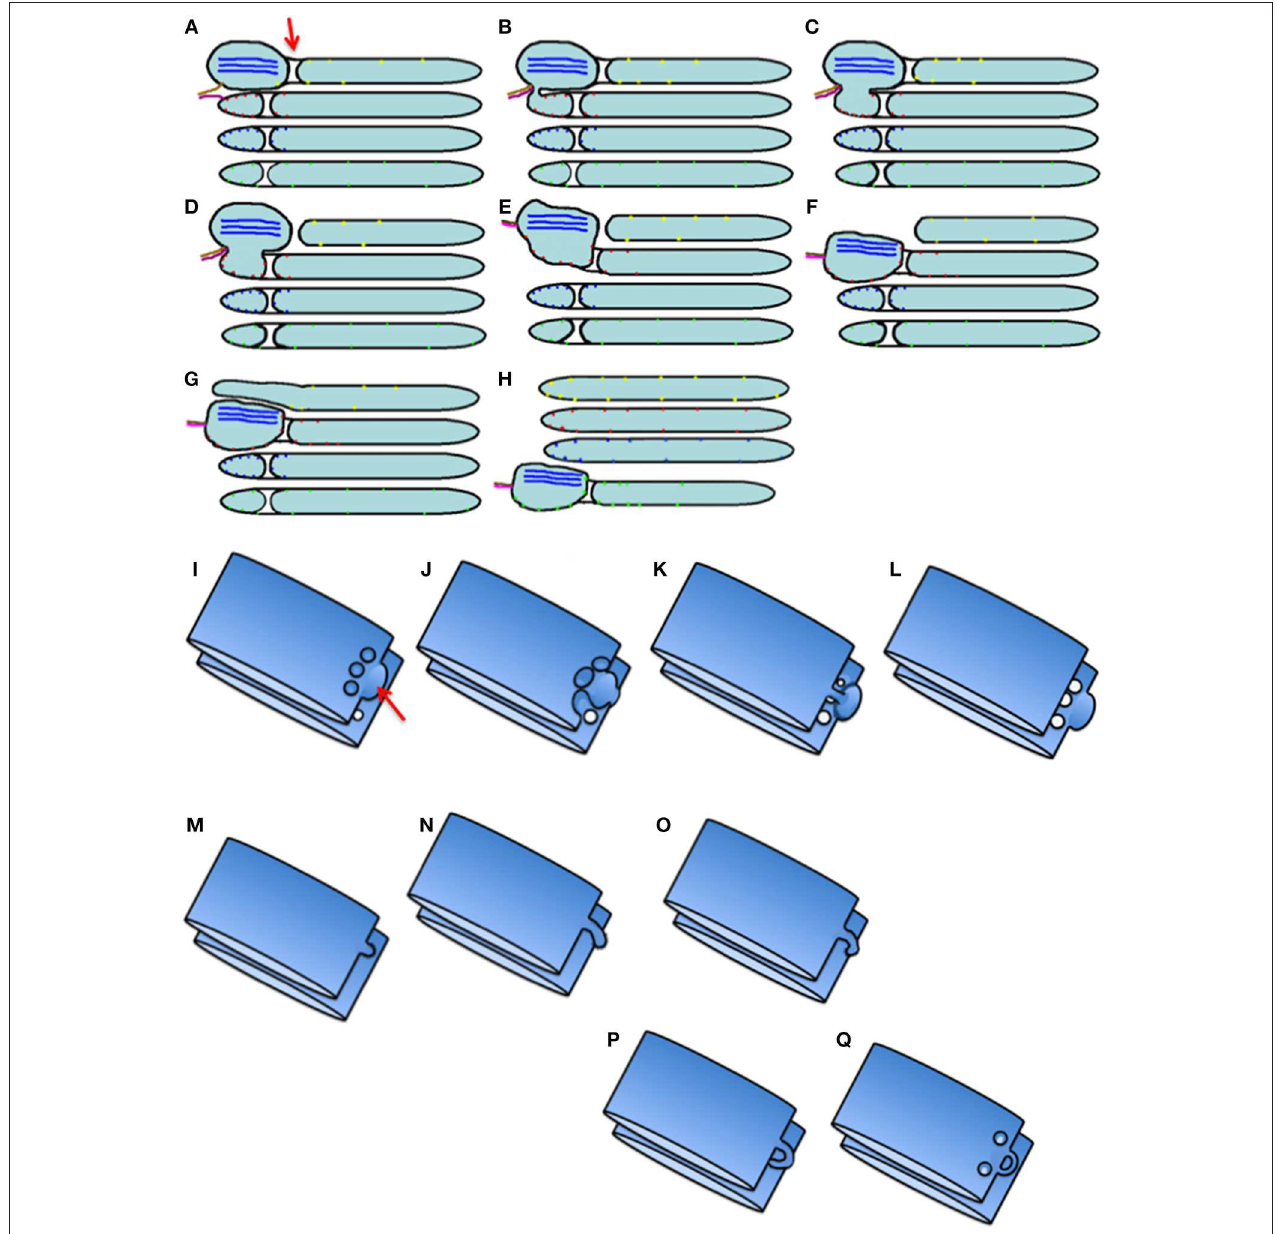
FIGURE 8 | Scheme of intra-Golgi transport according to the KARM. (A–H) Its main principle is the following: initially there is SNARE-dependent fusion with the distal Golgi cisterna, and then fission along the line of the pore row. (I–Q) Scheme showing only two cisternae in three-dimensions. (I) Formation of the cargo domain (red arrow) separated by the row of pores. (J) Fusion the domain with the distal cisterna and enlargement of pores. (K) Break down of two tubules surrounding pores. (L) Break down of the last tubule connecting the domain with the proximal cisterna. (M–Q) Stages of pore formation, when membrane bud grows and then fuses backward to the same cisterna. During the transport wave, there is consumption of the cisternal pores. Images similar to Figure 8B can be found in Trucco et al. (2004) (see their Figures 3l–n).